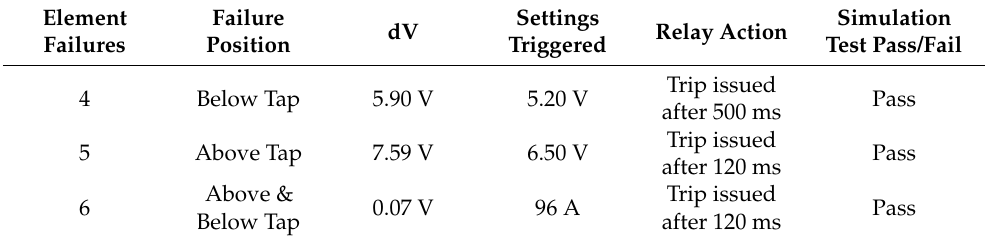
Table 6. Simulation results summary for the considered test case